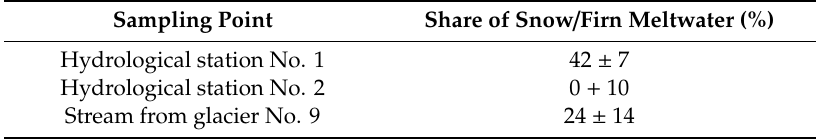
Table 4. The shares of snow meltwater according to the results of isotope separation.